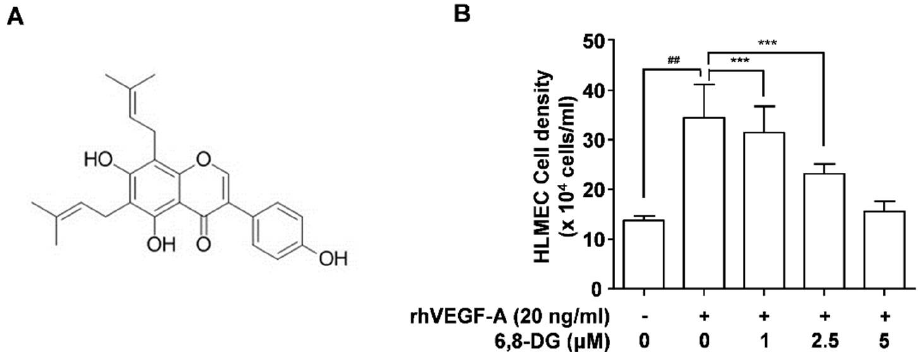
Figure 1. Structure of 6,8-diprenylgenistein (6,8-DG) and effects of 6,8-DG on VEGF-A-induced human lymphatic microvascular endothelial cells (HLMEC) proliferation. ( A ) Structure of 6,8-DG. ( B ) Proliferation in HLMECs stimulated rhVEGF-A. Cells were detached and counted using a hemocytometer. Data are presented as a mean ± S.D. of three independent experiments ( ## p < 0.001, *** p < 0.001).